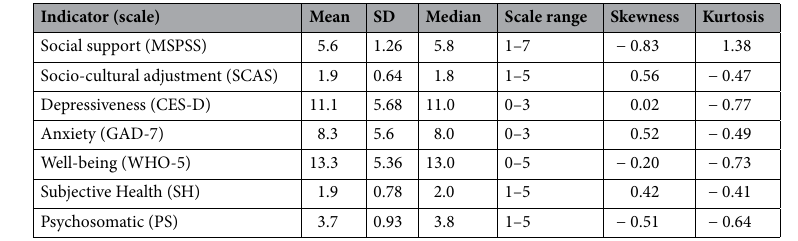
Table 2. Distributions of the main indicators under